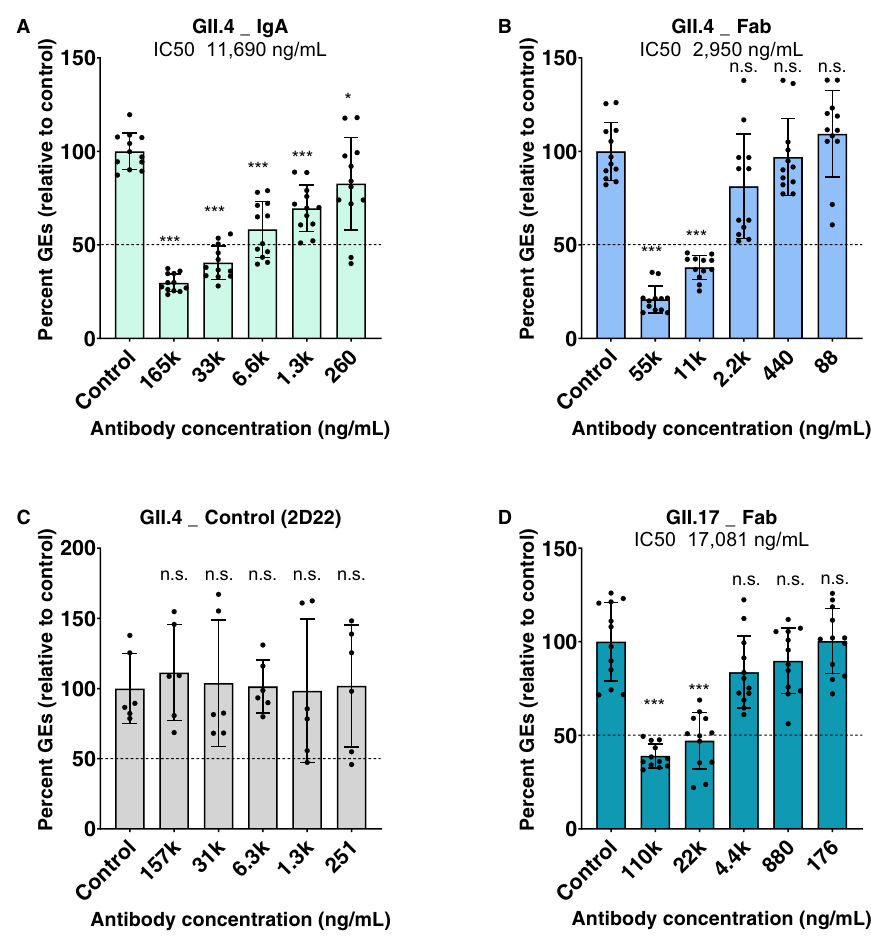
Fig. 5 Neutralization of GII.4 and GII.17 in human intestinal enteroid system. HuNoV was mixed with an equal volume of medium or dilutions of the indicated antibody, and then incubated at 37 °C for 1 h. Human intestinal enteroid monolayers were inoculated with each virus-antibody mixture for 1 h at 37 °C in the presence of 500 μ M GCDCA. The monolayers were washed twice and then cultured in the presence of GCDCA for 24 h. Compiled data from two experiments are presented. Each data bar represents the mean ± SD of six wells of inoculated HIE monolayers. Error bars denote standard deviation and individual points are shown ( n = 12 for IgA and Fab and n = 6 for GII.4_control). Percent reduction in viral genome equivalents (GEs) relative to medium (100%) was determined. The dotted line represents 50% neutralization. Signi fi cance relative to the control was determined using two-tailed Student ’ s t test. Exact ρ values from left to right: ( A ) *** ρ = 1.10E − 16, 2.30E − 13, 4.78E − 08, 9.70E − 07, * ρ = 0.03; ( B ) *** ρ = 1.3E − 13, 1.13E − 11; ( C ) all differences are n.s., not signi fi cant; ( D ) *** ρ = 2.45E − 09, 4.13E −